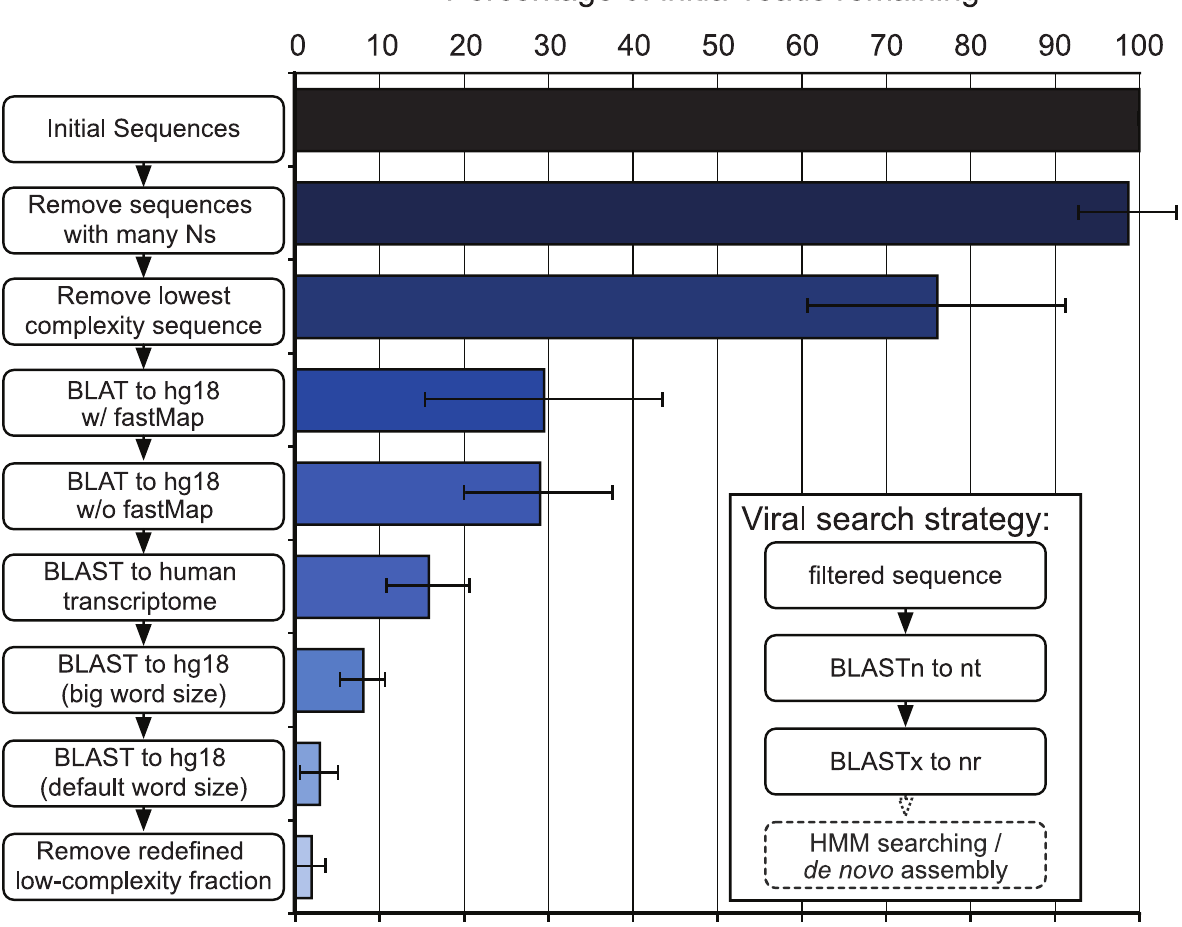
Figure 1. Bioinformatic filtering of deep sequencing data. Average percent remaining reads after each of the filtering steps. Low-quality and low-complexity reads are removed first, followed by iterative BLAT and BLAST comparisons to human sequence. Averages were calculated for all samples (n=130). Inset: secondary pipeline depicting post-filtering viral searches. The dashed bubble includes future methods to improve the sensitivity of viral sequence